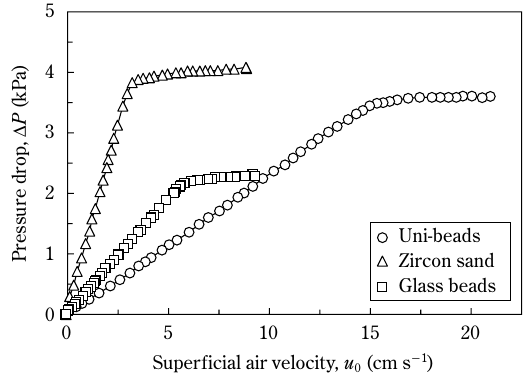
Fig. 3 Dependence of pressure drop on superficial air